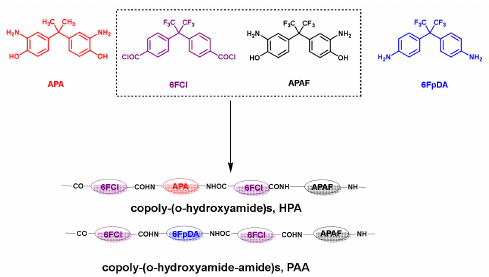
Figure 1. General polymerization reaction for copoly- o -hydroxyamides and copoly- o -hydroxyamide-